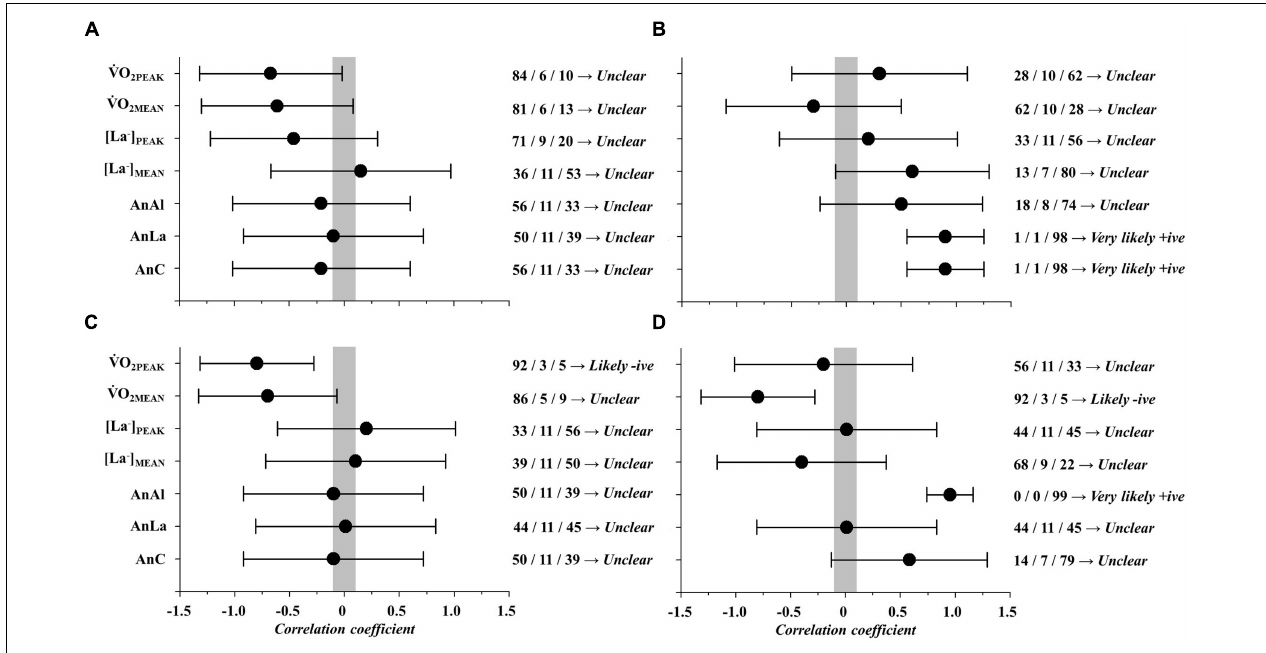
FIGURE 5 | Magnitude-based inference correlations between physiological parameters during simulated games (GaM) and GTP. ˙VO 2PEAK , peak oxygen consumption; ˙VO 2 MEAN , mean oxygen consumption; s˙VO 2PEAK , speed correspondent to ˙VO 2PEAK ; [La − ], blood lactate concentrations, expressed in [La − ] PEAK , peak blood lactate concentrations; [La − ] MEAN , mean peak blood lactate concentrations; AnAl, anaerobic alactic; AnLa, anaerobic lactic; AnC, anaerobic contribution. (A) Correlation between GaM and throws; (B) Correlation between GaM and defenses; (C) Correlation between GaM and recovery; (D) Correlation between GaM and